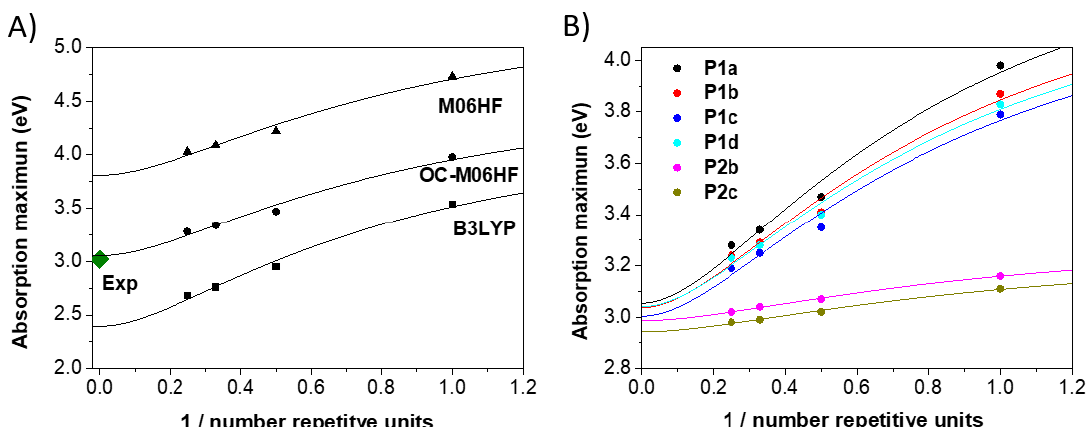
Figure 3. ( A ) Evolution of the S 0 → S 1 vertical transition energy with respect to the inverse number of repeat units (1 / n) at the TD-DFT level using the M06HF and B3LYP functionals for P1a . The OC-M06HF values with an o ff set correction (OC) of − 0.75 are also shown. Solid lines are fitted according to the Kuhn equation. The experimental E vert value, taken as the absorption band maximum of the lowest-energy transition, is shown as a green square. For the rest of the polymers, see Figure S7 in Supporting Information. ( B ) Evolution of the S 0 → S 1 vertical transition energy with respect to the inverse number of repeat units (1 / n) at the TD-DFT level using the OC-M06HF functional for P1 – P2 .